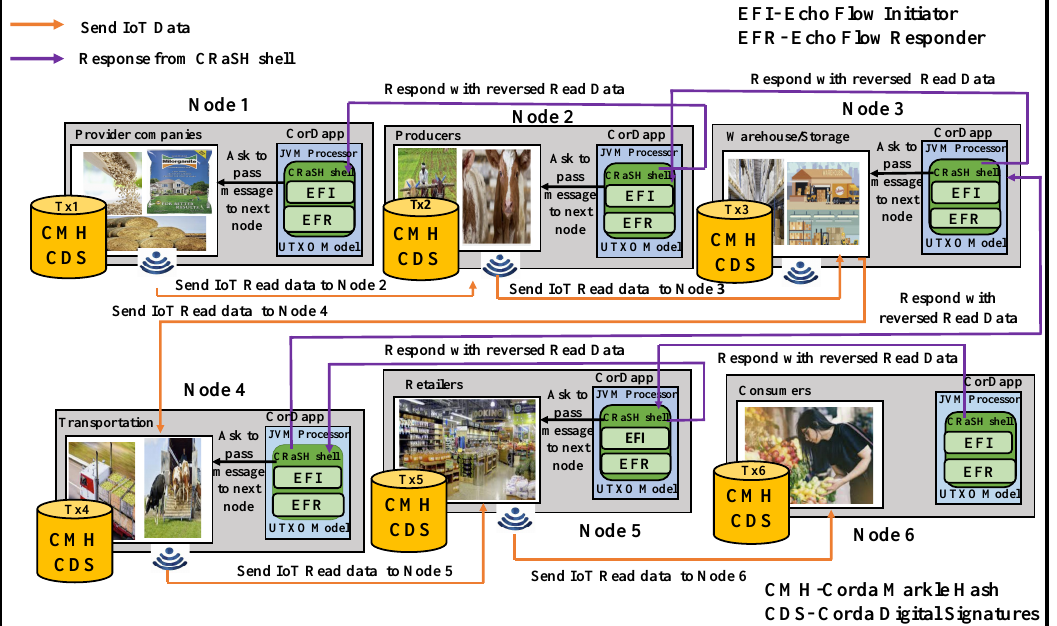
Figure 7. Proposed agroString architecture with IoAT and